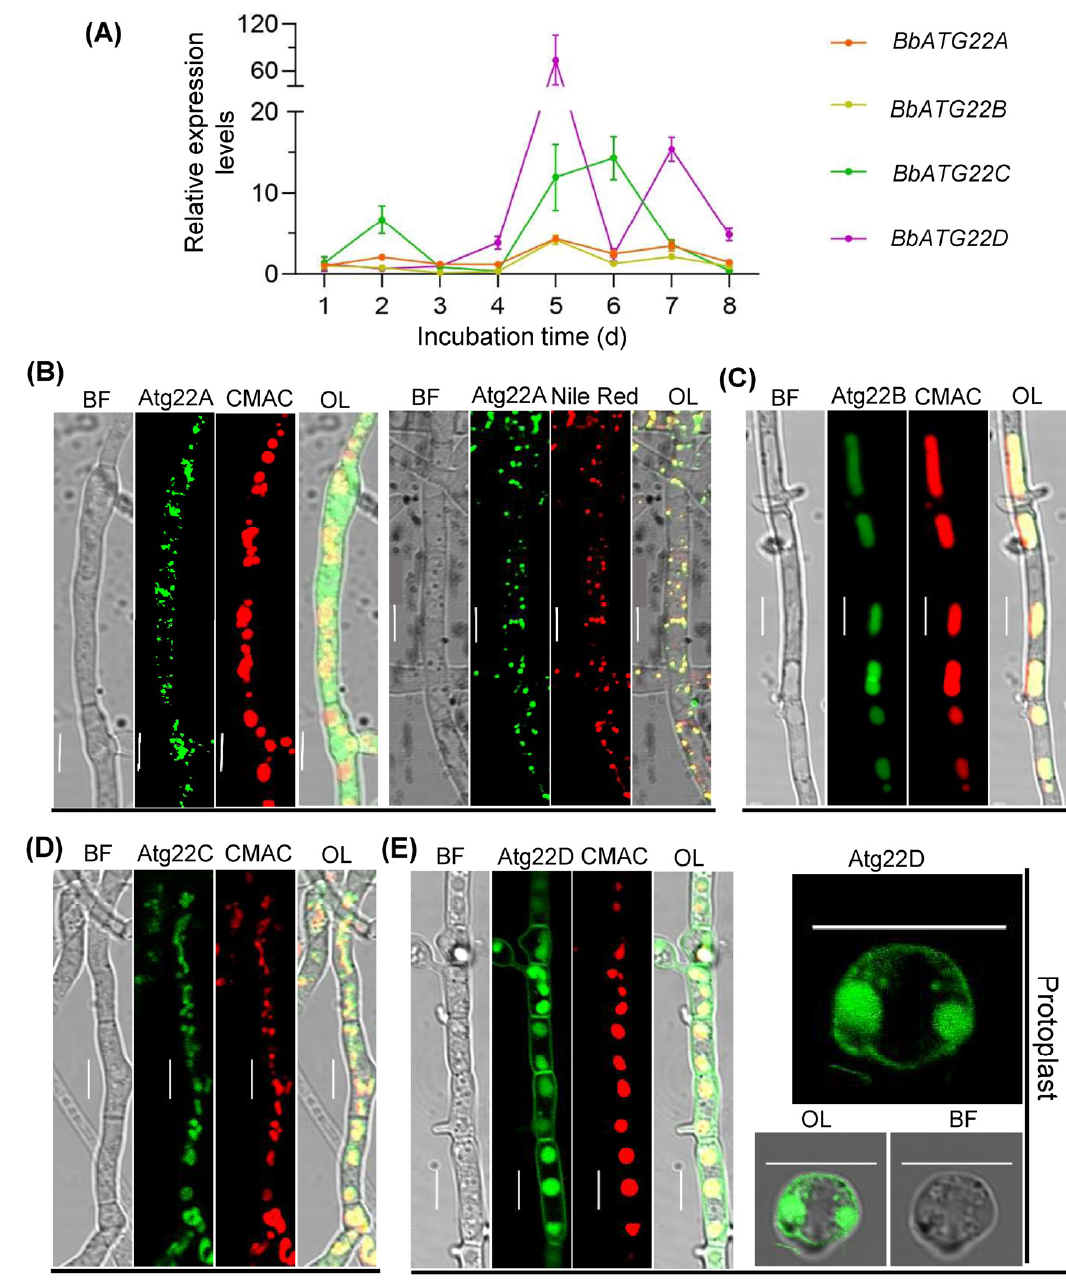
Figure 2. Expression profiles of four Atg22-like protein genes and sub-cellular localization of their proteins. ( A ) Relative transcriptional levels of four Atg22-like protein genes. Conidia of the wild type strain were inoculated on SDAP plates and cultured at 25 °C for 8 d. At the indicated time point, fungal cells were sampled, and the gene expression levels were analyzed with quantitative PCR. ( B – E ) Sub-cellular localizations of four Atg22-like proteins. Atg22-like protein gene was fused to green fluorescent protein gene, and the fusion gene was transformed into the wild type strain. The 2-day-old mycelia for the transgenic strain were harvested from SDB, and fluorescent images were examined under a fluorescence microscope. Vacuole-specific dye (CMAC) and lipid-specific dye (Nile Red) are showed in red. Scale bars: 5 µ m. In panel E, the association of Atg22D with cyto membrane was verified in a protoplasting experiment.